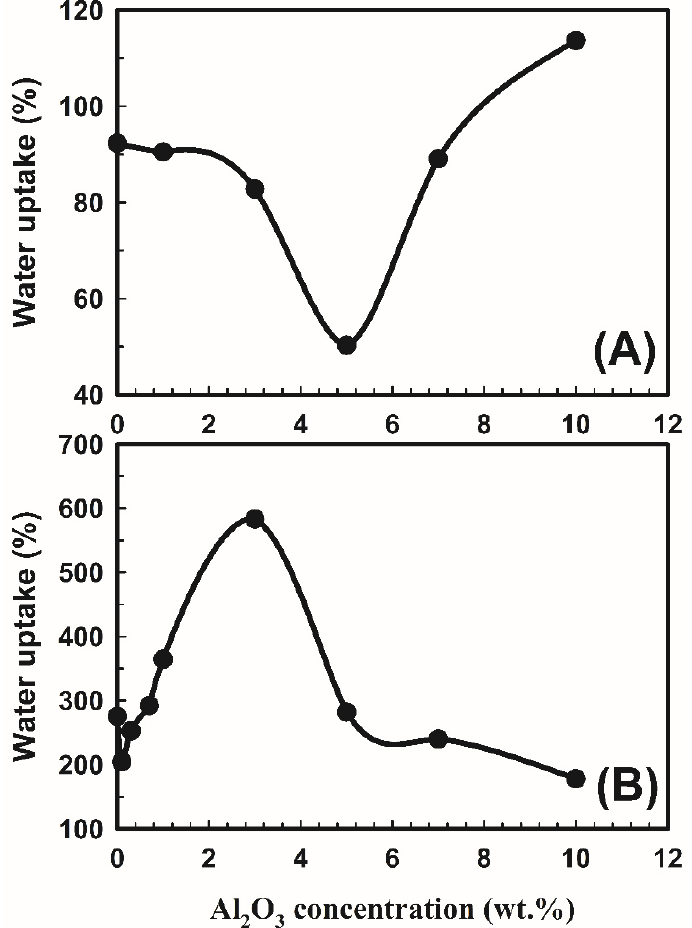
Figure 5. The water uptake for the different concentrations of Al 2 O 3 on the membrane: ( A ) PVA/10 wt.% PEG polymers and ( B ) PVA/10 wt.% PEG/20 wt.% SSA membranes. ( A ) PVA/10 wt.% PEG polymers and ( B ) PVA/10 wt.% PEG/20 wt.% SSA